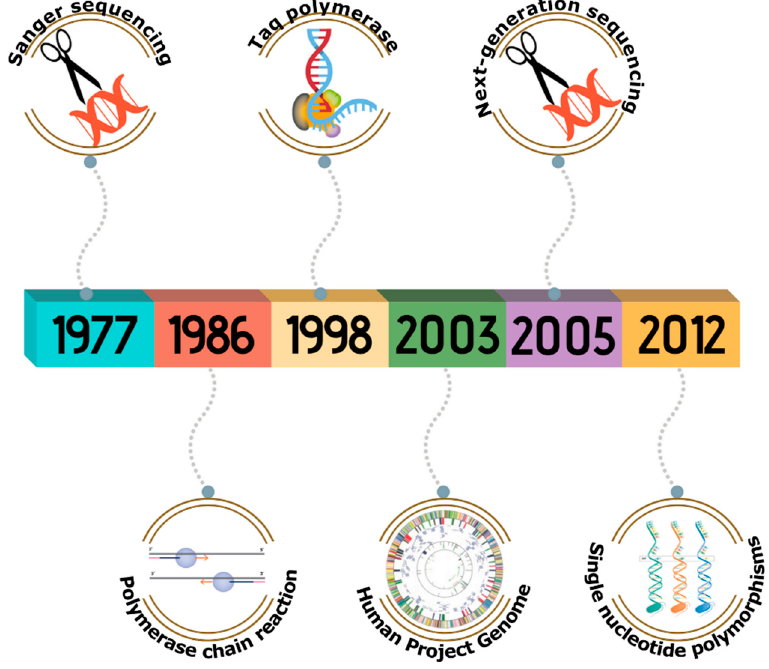
Figure 1. A brief history of molecular diagnostics.